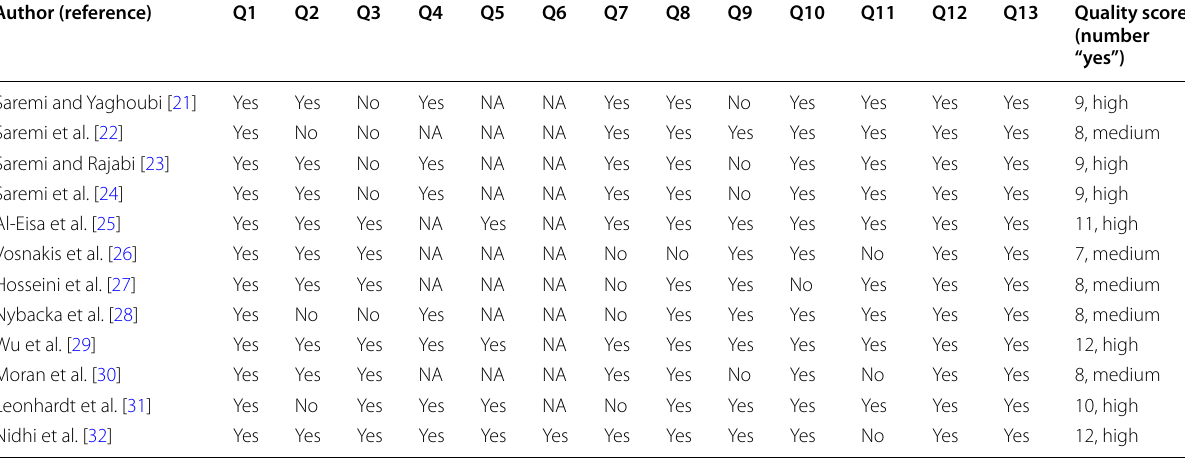
Table 2 Qualitative evaluation of studies based on JBI checklist items Author